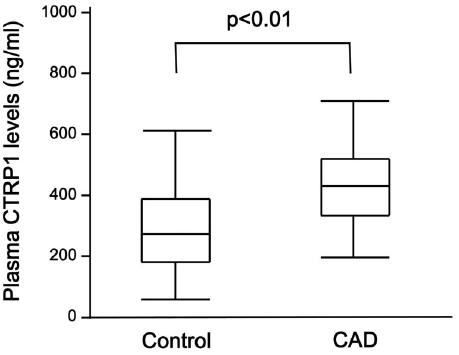
Figure 1. Plasma CTRP1 levels in control subjects and patients with CAD. Plasma concentration of CTRP1 in control subjects (n=64) and CAD patients (n=76) was measured by ELISA